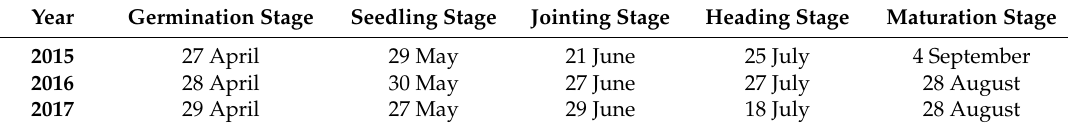
Table 2. Maize biomass sampling time